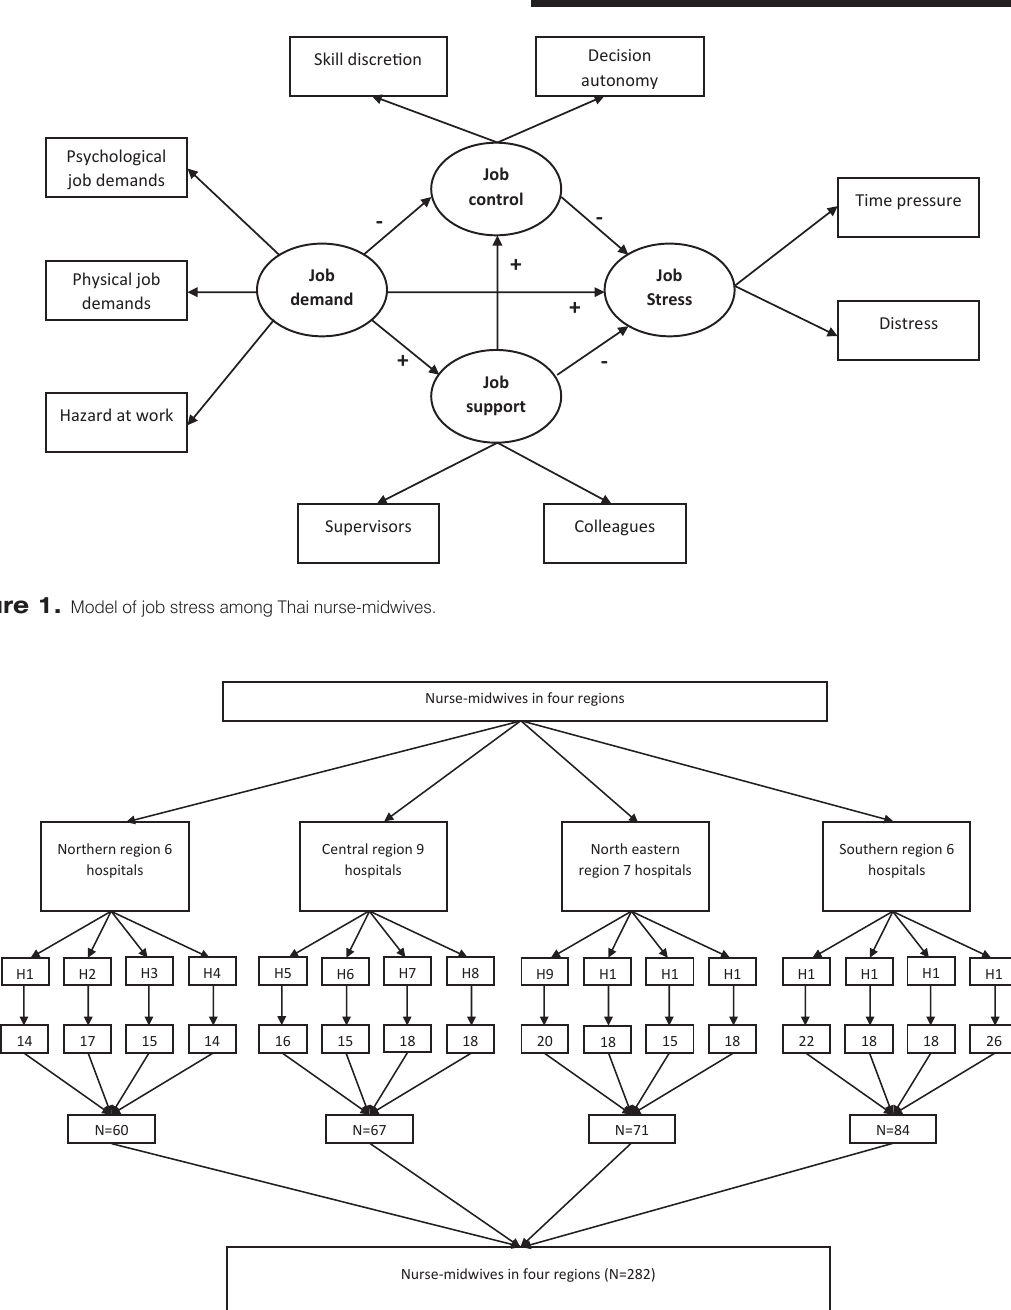
Scale is composed of two-components: time pressure and psychological distress. The five-point Likert scale has response options ranging from 1 ( strongly disagree ) to 5 ( strongly agree ). Summed scale scores can range from 13 to 65 with higher scores indicating higher levels of job stress. For this study, the Cronbach’s alpha of the Job Stress Scale–Thai version was